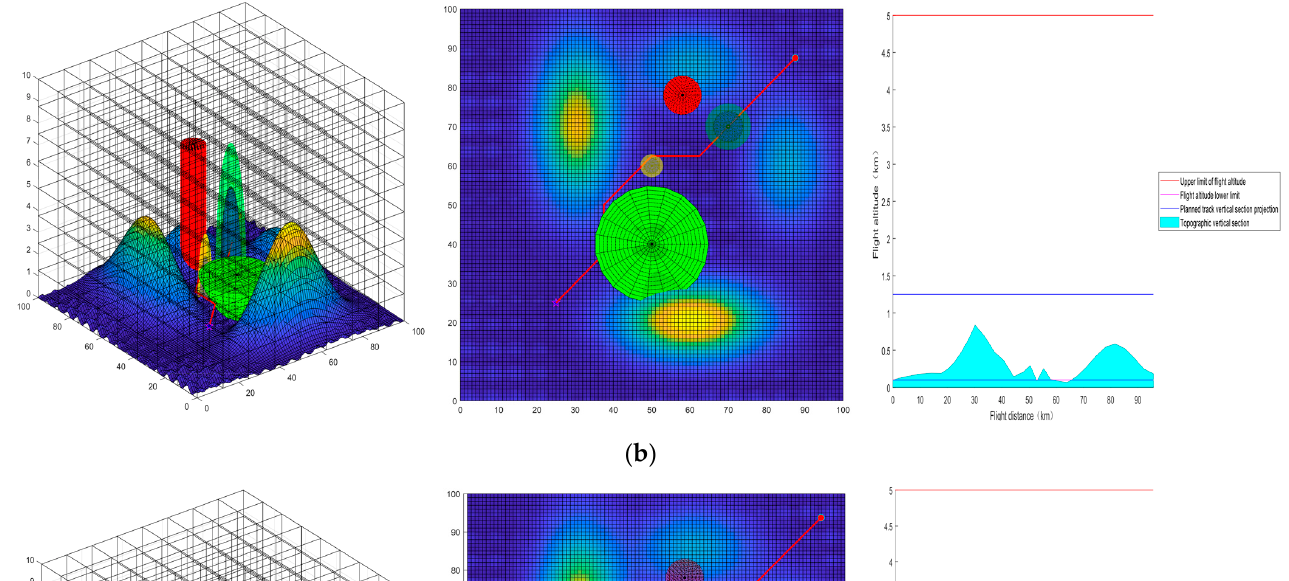
( e ) Figure A3. When = 4 N , the comparison experiment of the route planning algorithm’s planning result, top view, and altitude change curve. ( a ) Grid-based route planning with the A* algorithm, ( b ) A* algorithm route grid point-based planning, ( c ) Grid-based route planning with Lazy Theta* algorithm, ( d ) Grid point-based Lazy Theta* route planning, and (e ) RRT* route planning using 12.5- steps. (3) = 5 N . When the grid level is 5, the route planning effect is depicted in Figure A4. ( a )